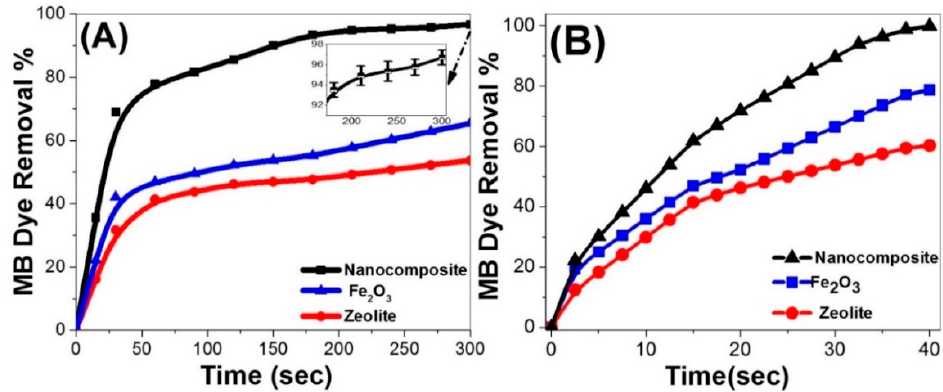
Figure 5. The photocatalytic degradation of 100 mL MB dye solution of concentration 10 mg/L at pH 7 using zeolite, Fe 2 O 3 , and Fe 2 O 3 -zeolite photocatalyst ( A ) 20 mg, and ( B ) 60 mg. The inset shows the statistical error bars.